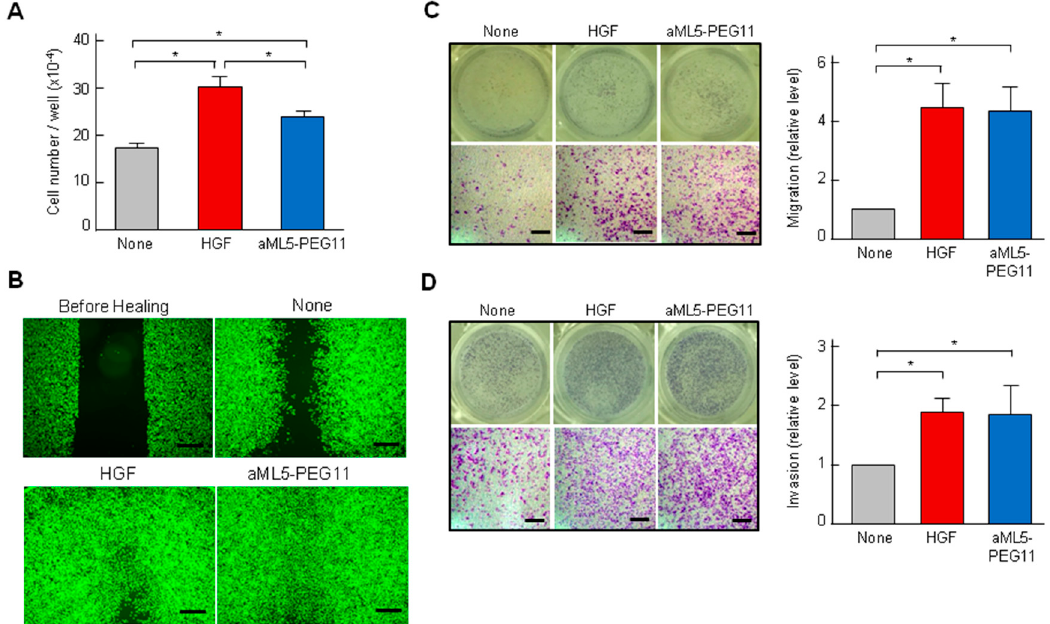
Figure 2. Biological responses triggered by aML5-PEG11. ( A ) Cell proliferation. HuCCT1 cells were cultured with or without 100 nM aML5-PEG11 or 3.3 nM HGF. After six days, cell numbers were counted by means of an automated cell counter. Each value indicates the mean ± SD of triplicate measurements. The asterisk indicates a significant difference ( p < 0.05). ( B ) Scratch wound healing. After scratch wounding, HuCCT1 cells were cultured for 20 h in the absence or presence of 100 nM aML5-PEG11 or 3.3 nM HGF and images were captured. Similar results were obtained in triplicate experiments. Representative images are shown. Scale bars: 500 µ m. ( C ) Cell migration. HuCCT1 cells were seeded on trans-well chambers and cultured for 20 h. Scale bar: 200 µ m. ( D ) Cell invasion. HuCCT1 cells were seeded on trans-well membranes coated with type-IA collagen and cultured for 24 h. Scale bars: 200 µ m. In C and D, cells that migrated through the membrane were visualized by crystal violet staining. Each value indicates the mean ± SD of triplicate measurements. The asterisk indicates a significant difference ( p < 0.05). Representative images are shown.